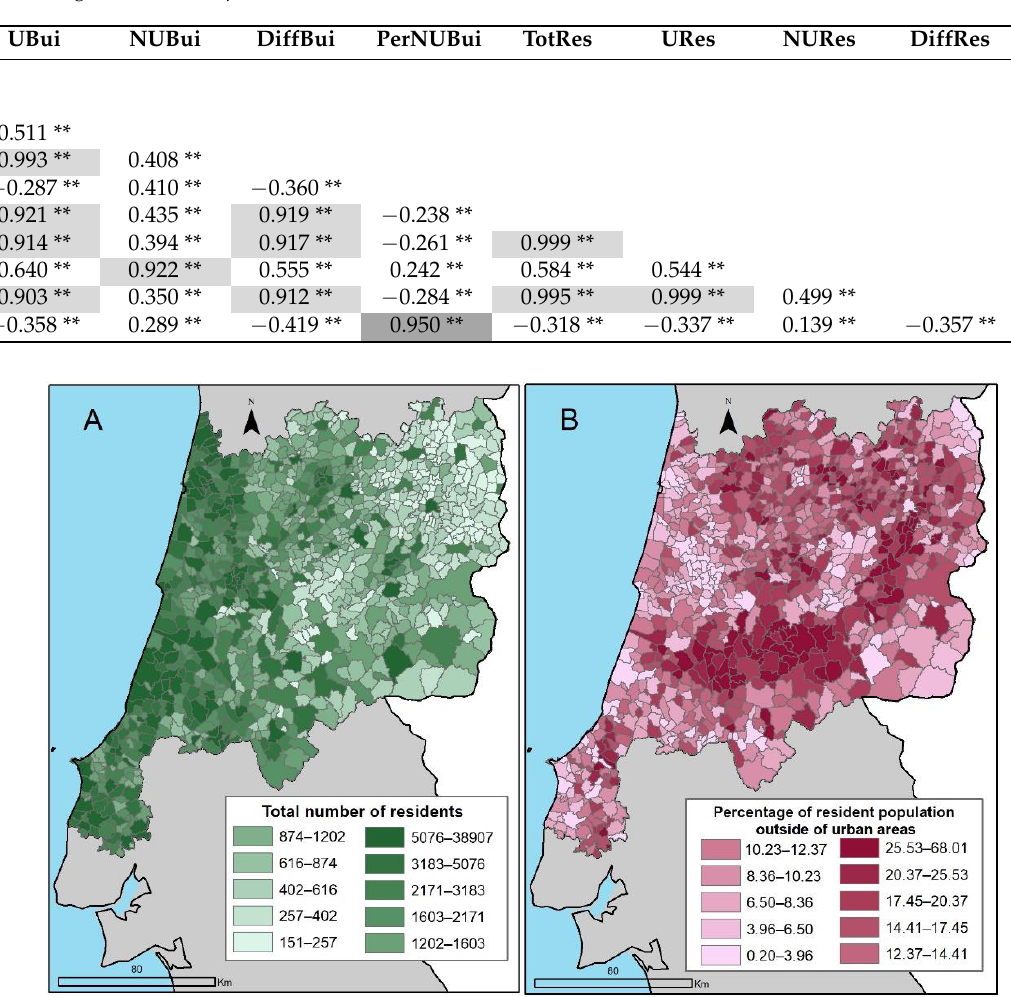
Figure 6. ( A ) total number of residents by parish; ( B ) — percentage of resident population outside the boundaries of the consolidated urban areas by parish. Both variables were classified in deciles. Table 1. Pearson correlation coefficients between the potential exposure descriptors. Values ≥ 0.7 highlighted in grey. The two grey tones are intended to differentiate groups of collinear variables, considered to express different dimensions of exposure. TotBui — total number of buildings; UBui — number of urban buildings; NUBui — number of non-urban buildings; DiffBui — difference between urban and non-urban buildings; PerNUBui — percentage of total buildings that are non-urban; To- tRes — total number of residents; Ures — urban residents; NURes — non-urban residents; DiffRes — difference between urban and non-urban residents; PerNURes — percentage of total residents that are non-urban. ** Significant at the p = 0.01 level.